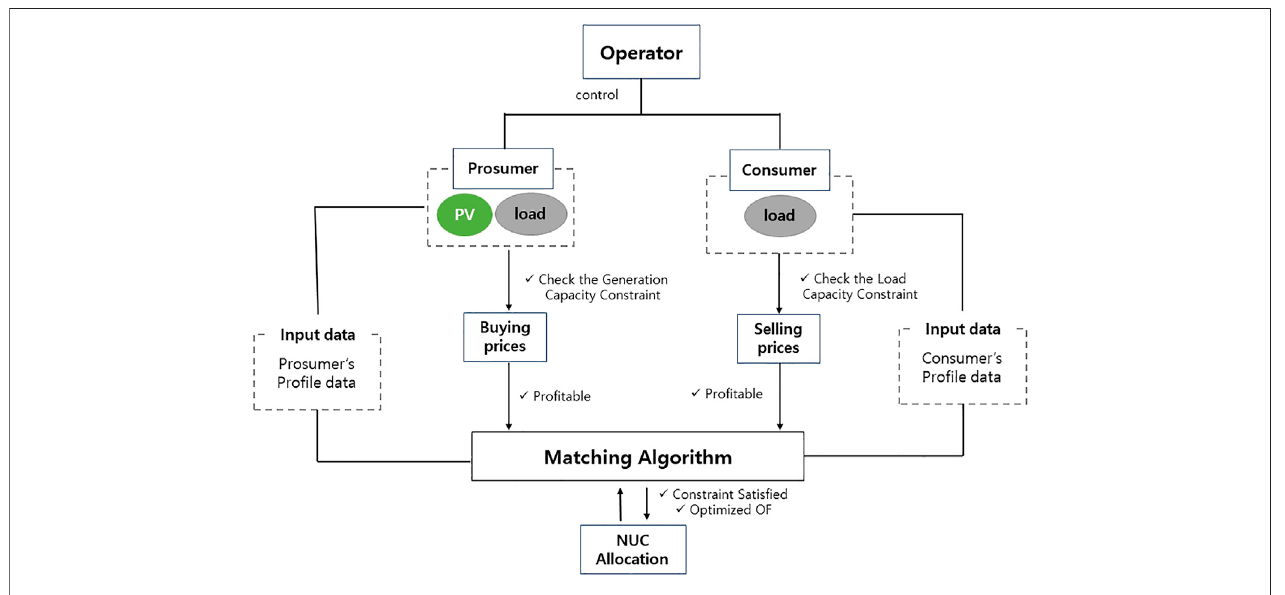
FIGURE 1 | Operator-oriented P2P market